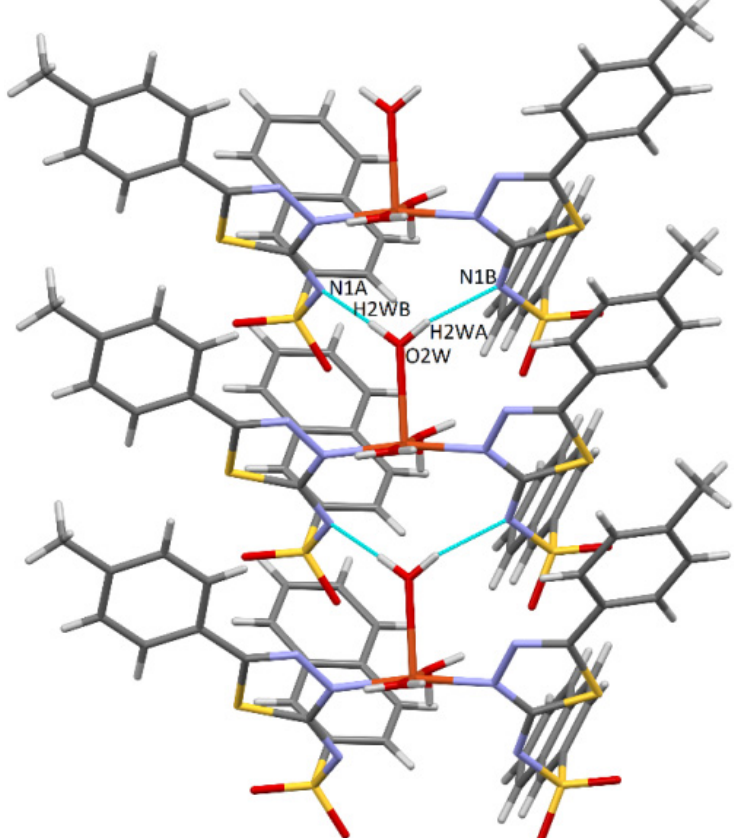
Figure 3. Bifurcated O ‐ H ∙∙∙ N hydrogen bonds in complex C1.